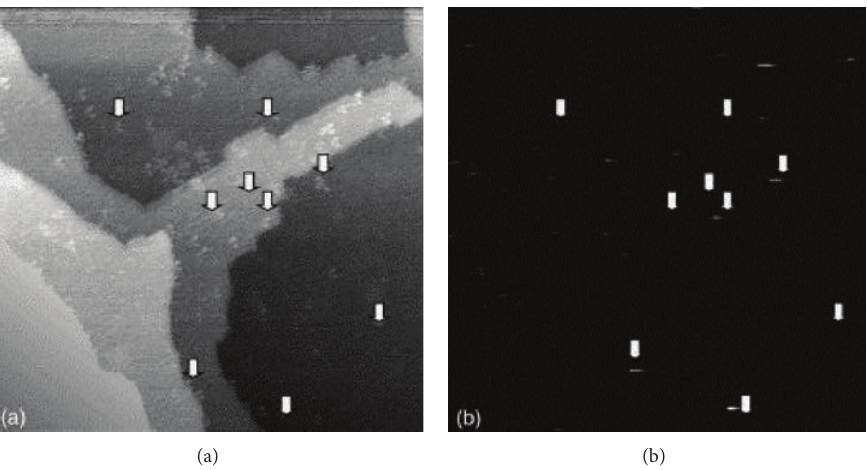
Figure 6: STM images of oxygen deficient TiO 2 surface before (a) and after (b) visible light irradiation [87].